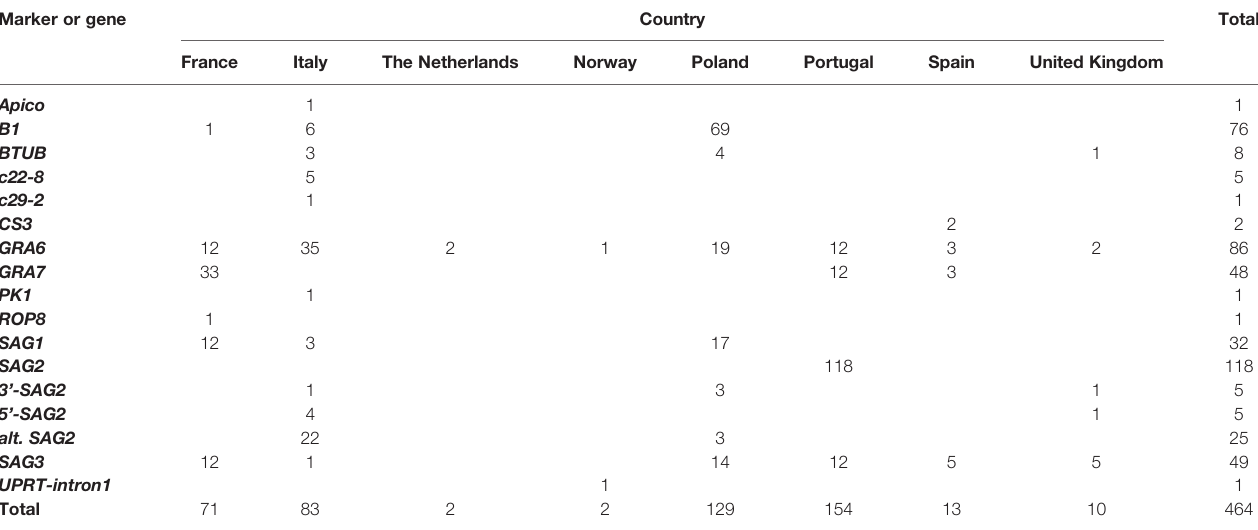
TABLE 2 | Summary on sequence data available in GenBank for European Toxoplasma gondii isolates and samples. Marker or gene Country